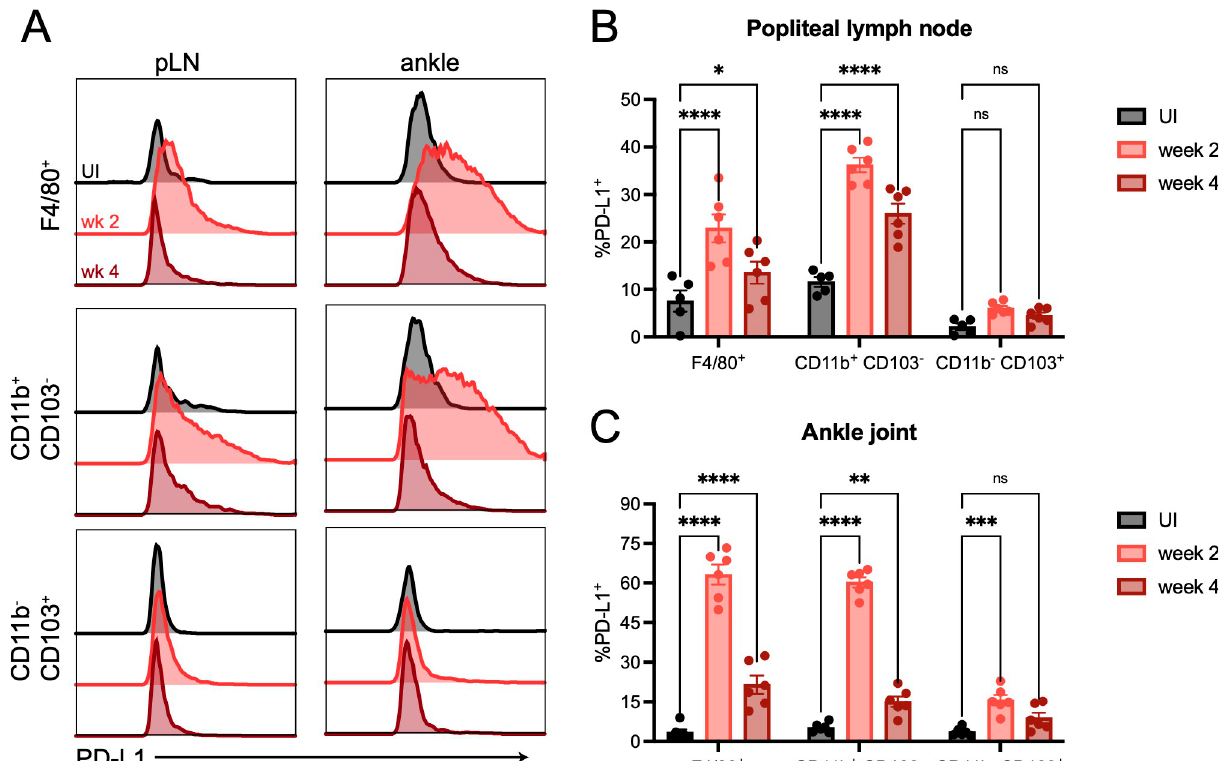
Fig 2. PD-L1 is upregulated on macrophages and CD11b + CD103 - dendritic cells in the draining lymph nodes and ankle joints following murine B . burgdorferi infection. WT mice were inoculated with B . burgdorferi or media alone and sacrificed at two and four weeks post-infection. (A, B) Popliteal lymph nodes and (A, C) ankle joints were harvested and assessed for flow cytometry. Data are pooled from two independent experiments with at least 5 mice per group and were analyzed using two-way ANOVA with Dunnett’s multiple comparisons